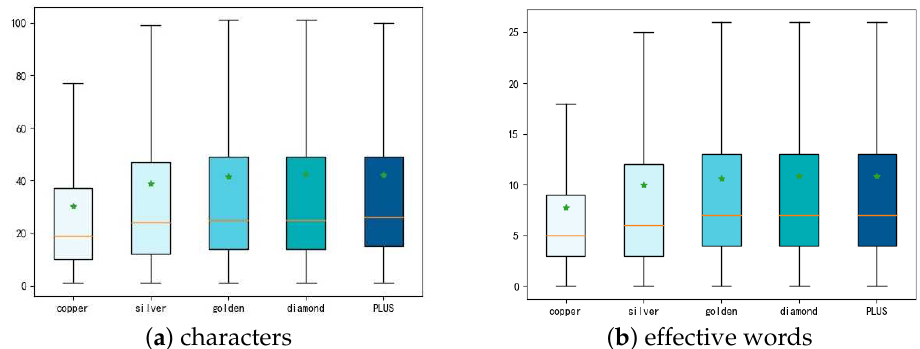
Figure 7. Rough distribution of negative review length in characters and effective words for all five user levels. ( a , b ) are no-fliers boxplots for negative review length, in characters and effective words, respectively. In each plot, the x -axis refers to different user levels rising from left to right and the y -axis refers to review length. Moreover, the growth of reviews with user levels is statistically significant in the one-way t